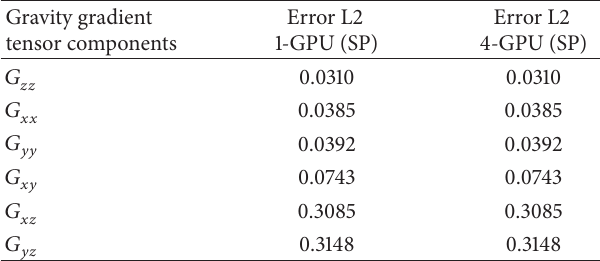
Table 4: Errors of the components of the gradient tensor of gravity in single precision, with respect to its sequential